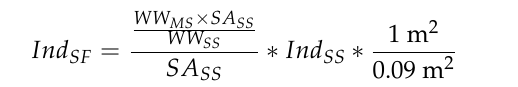
sub sample ( SA SS ) (0.09 m 2 corresponds to the size of the sampling